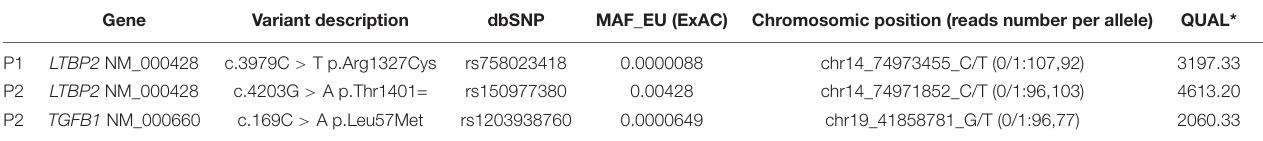
TABLE 1 | Discrepant genetic variants analyzed in the study. Gene